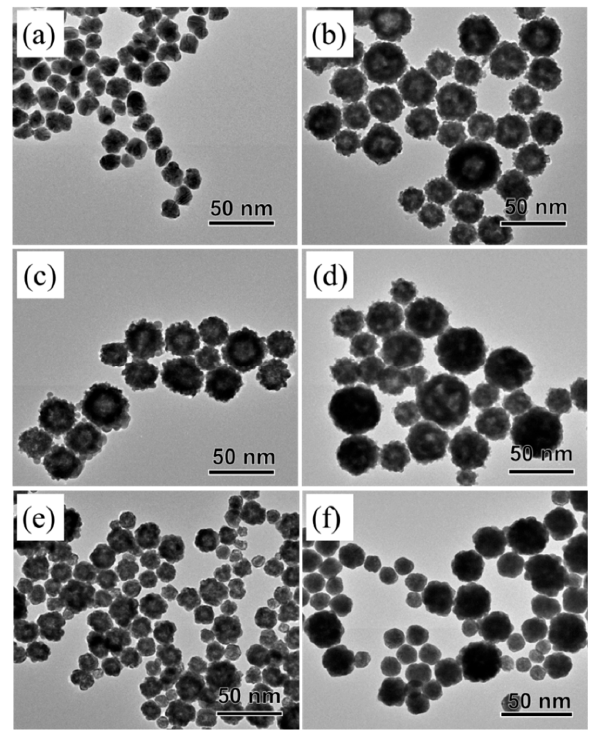
Figure 1. Transmission electron microscopy (TEM) images of AgPt bimetallic nanoparticles at different molar ratios of Ag/Pt in precursor ( a ) AgPt-40, ( b ) AgPt-10, ( c ) AgPt-6.7, ( d ) AgPt-5, ( e ) AgPt-2, and ( f ) AgPt-1.